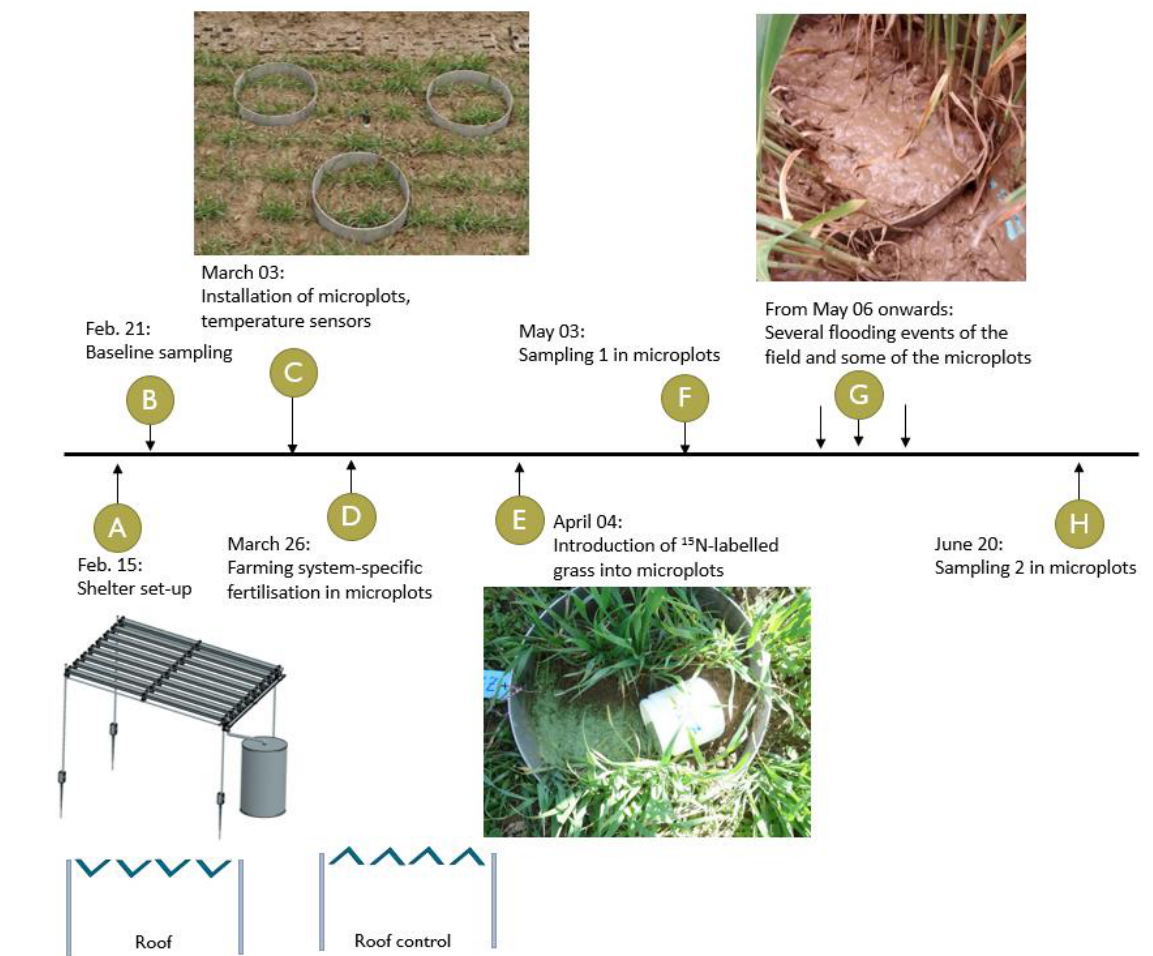
Figure 1. Timeline for the experiment carried out in